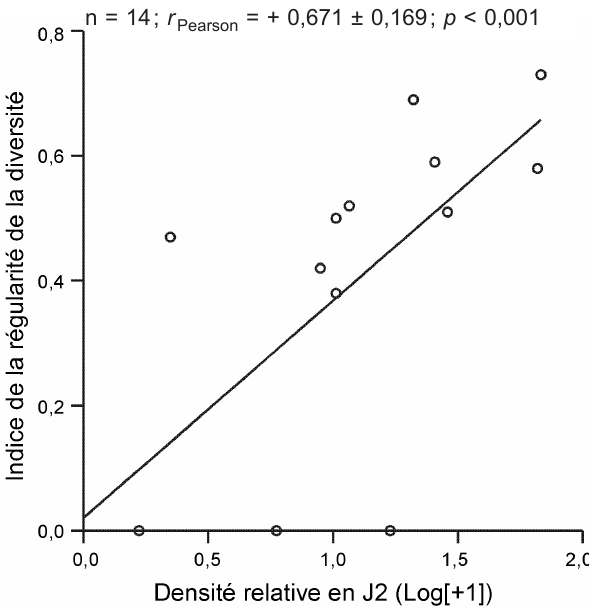
n = 14; r = + 0,671 ± 0,169; p < Pearson